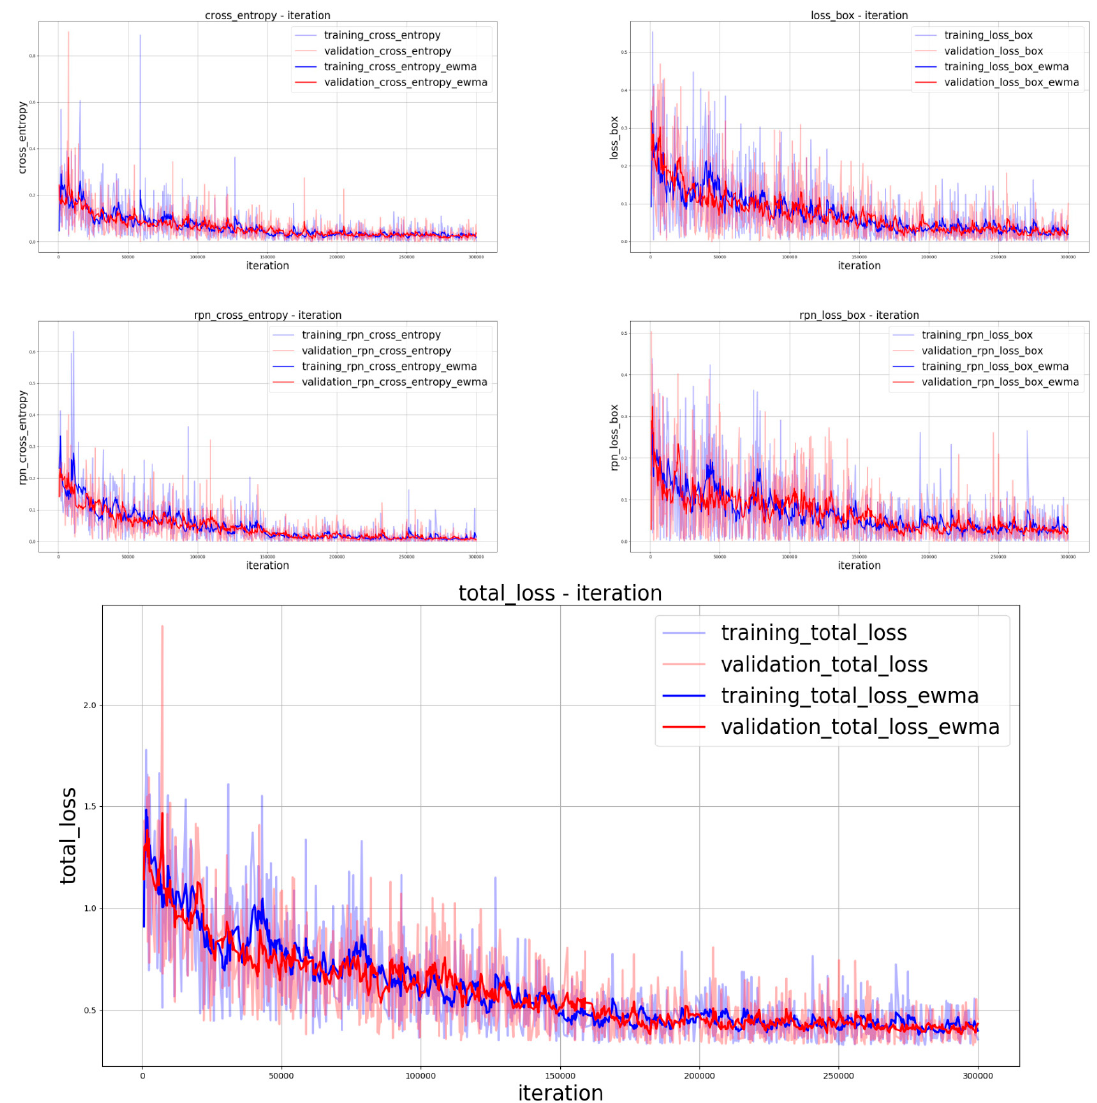
Figure 17. Training and validation loss of the Faster R-CNN [5] with ResNet101 [2]. Upper left: Cross-entropy loss. Middle left: RPN cross-entropy loss. Upper right: Bounding box loss. Middle right: RPN bounding box loss. Bottom: Total loss. Table 2. Performance of our nighttime validation data obtained using models trained with our nighttime training data.